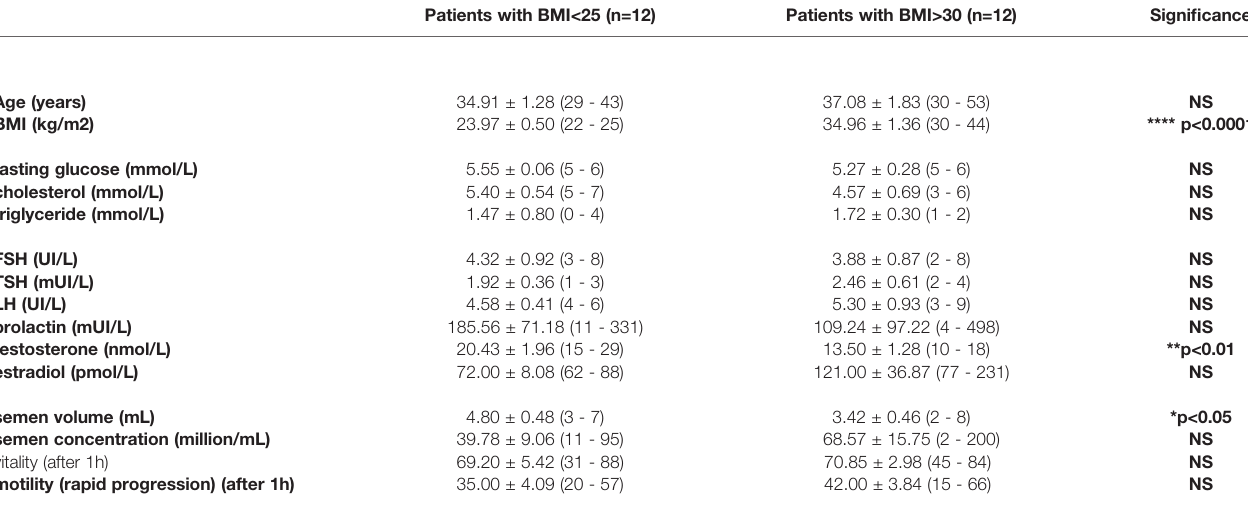
TABLE 1 | Biological and semen parameters of samples from the BMI ≤ 25 kg/m 2 group and the BMI ≥ 30 kg/m 2 group. Patients with BMI<25 (n=12) Patients with BMI>30